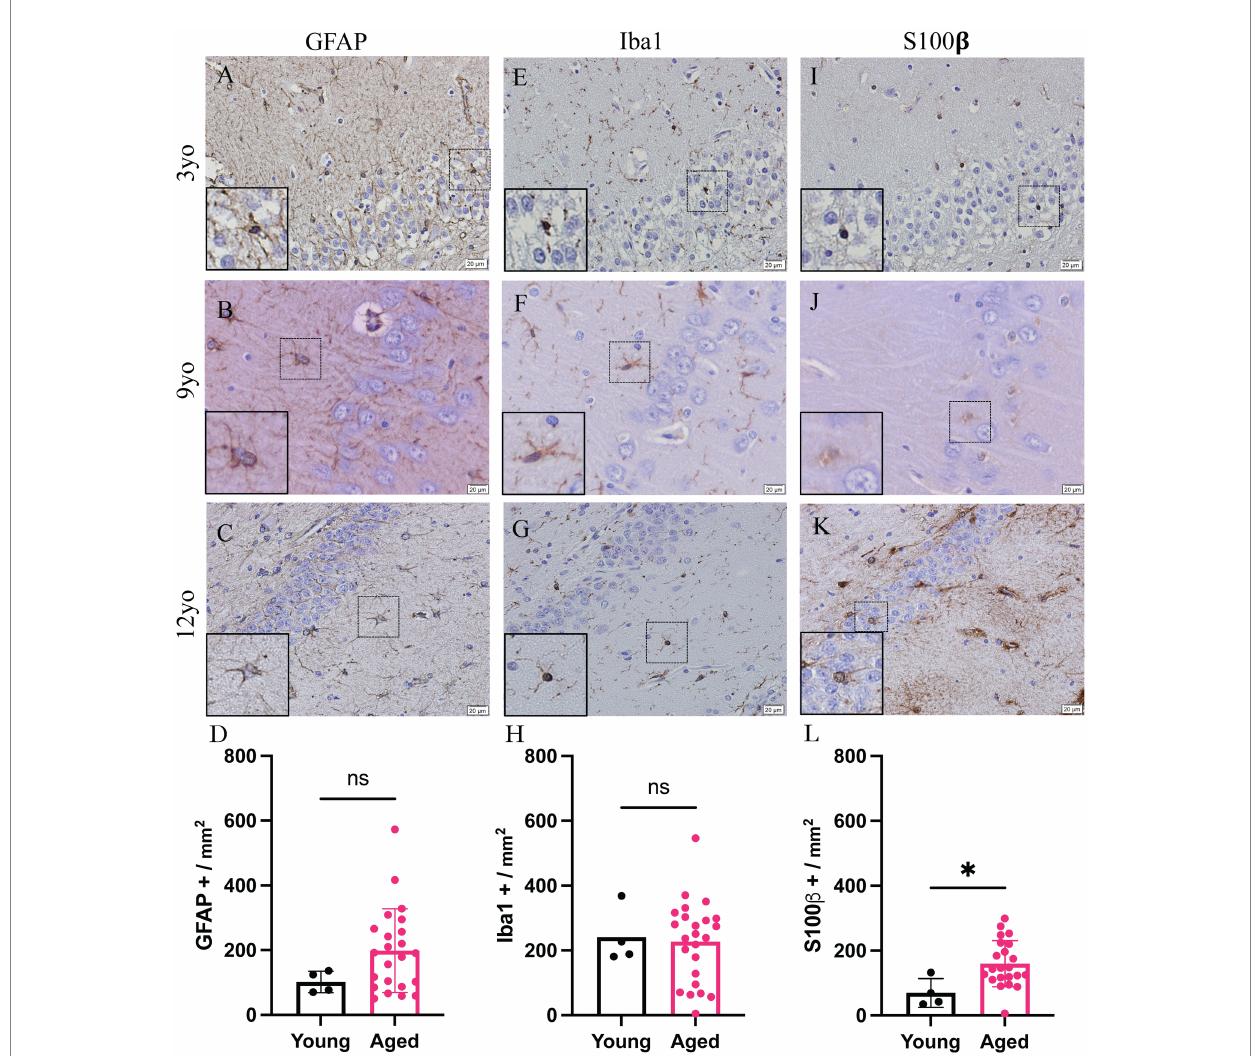
FIGURE 2 Increase glial reactivity in the hippocampus of aging canines. Increase in astrocyte reactivity detected by increase in S100 β + ( J–L ; n = 25) in the hippocampus of aged canines when compared to young canines ( A,E,I ; n = 4). No significant change was detected in GFAP+ (A–D) or Iba1 +